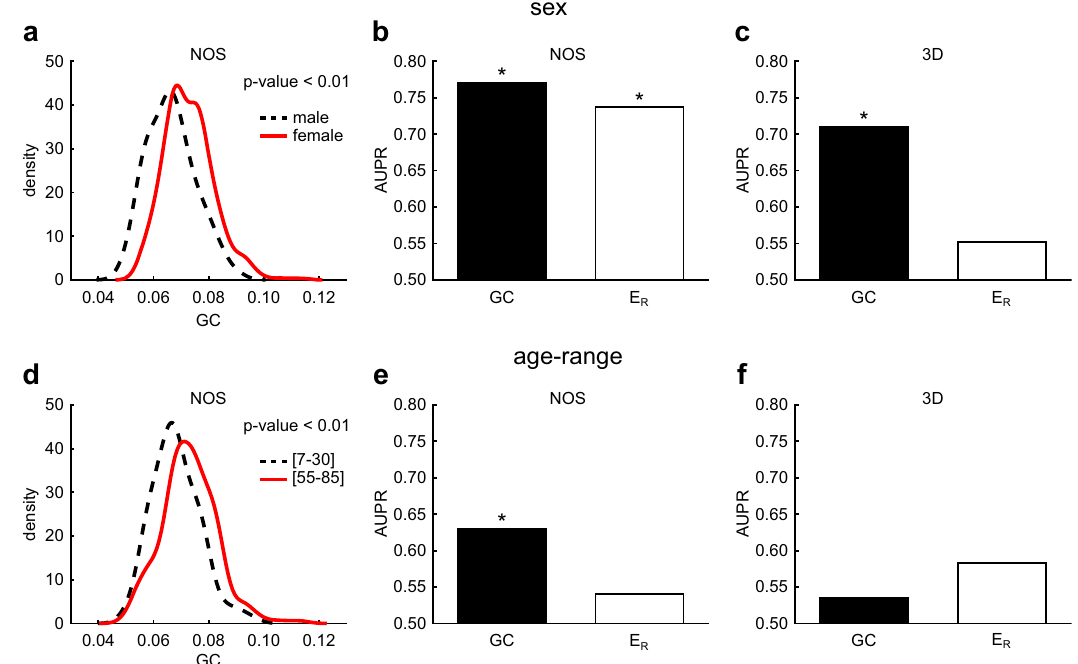
Fig.6|GCasmarkerforsexandagediscriminationinstructuralconnectomes. Wehaveanalyzedadatasetofstructuralconnectomeswithsexandageannotation. For each network, we have computed the GC(GSP, pTSP) and the E R with connec- tion weights based on NOS or 3D (see “ Methods ” for details). a We divided the connectomesintwogroupsrelatedtomaleandfemalesubjects,foreachgroupwe have estimated by kernel-density the probability density function of GC, which is reported in the subplot (male in black dashed line, female in red solid line): x -axis represents the GC(GSP, pTSP) and y -axis the density function. The p -value of the Mann – WhitneytestshowsthatGCcansigni fi cantlydiscriminatebetweenmaleand female connectomes ( p -value < 0.01). b , c The barplots compare the AUPR of GC and E R methods in discriminating between male and female connectomes, when